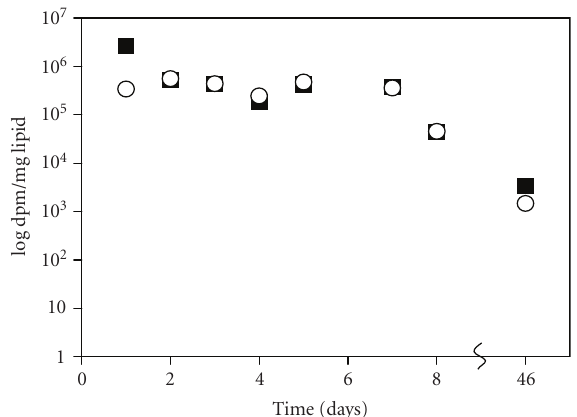
Figure 1: Clearance of radioactivity from [ 3 H]cholesterol instilled into rat lungs. Values represent total radioactivities in TLC-isolated bands corresponding to free sterols and steryl esters. BALF (circles) and postlavage lung (squares). Each value represents a single sample from an individual